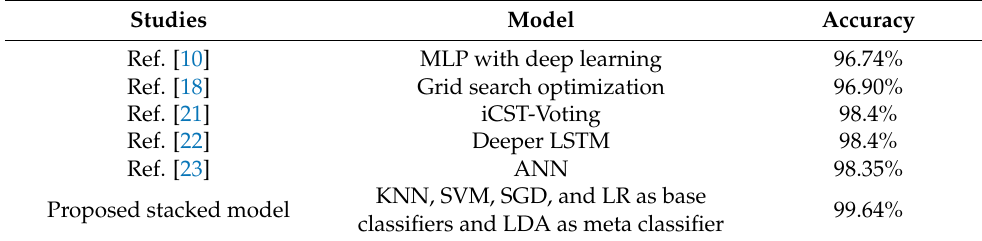
Table 6. Comparison of proposed stacked model with several